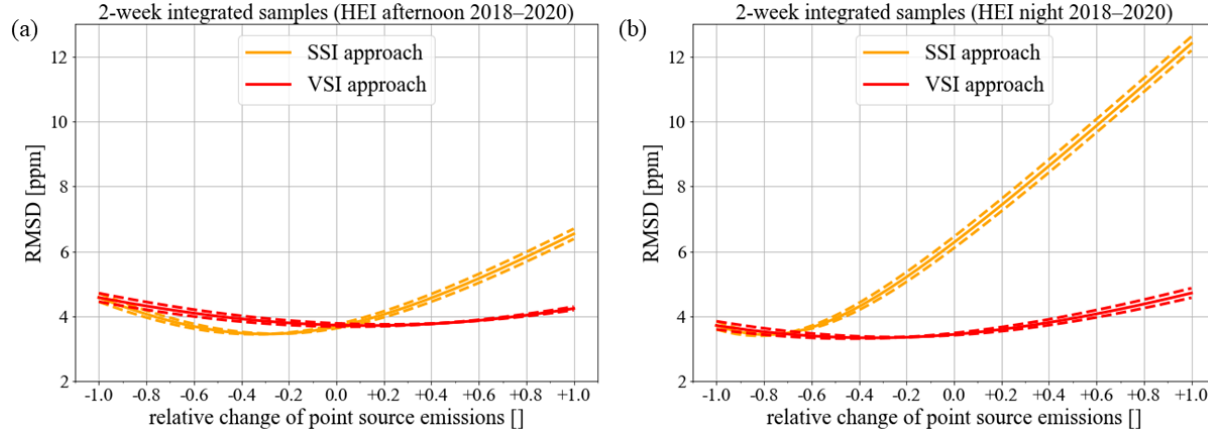
Figure 8. Root-mean-square deviation (RMSD) between measured and modelled ffCO 2 concentrations of 2-week integrated afternoon ( a ) and nighttime ( b ) (cid:49) 14 CO 2 samples collected during July 2018 and June 2020 in Heidelberg (HEI) at 30ma.g.l. for the surface (SSI, in orange) and volume source influence (VSI, in red) approaches for different relative changes in the TNO point source emissions. A relative change of − 1 means that all point source emissions are switched off, and a relative change of + 1 means that the actual emissions of all point sources are doubled. For instance, the actual point source emissions would have to be decreased by about 70% (corresponds to − 0 . 7 on the x axis), and thus SSI and VSI approach lead to a similar RMSD for nighttime situations. The dashed lines show the additional impact of a TNO area source emission uncertainty of ± 3% (see Super et al., 2020) on the RMSD between measured and modelled ffCO 2